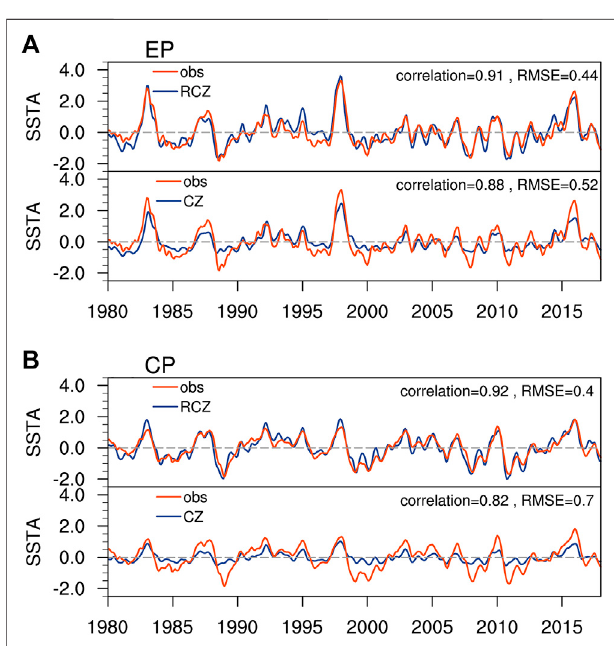
FIGURE 8 | (A) upper panel : Time series of the observed (red line) and RCZ-simulated (blue line) equatorial (5 ° S – 5 ° N average) EP SSTA (i.e., averaged between 140 ° W and 90 ° W). The correlation between the red lineandtheblueline,alongwiththestandardizedrootmeansquareerror of the simulated EP SSTA, is indicated in the upper-right corner. Settings of the model simulation are the same as that in Figure 5 . SSTA has been smoothedthroughthe3-monthrunningaverage. (A) lowerpanel :Sameasthe upper panel, except that the blue line denotes the CZ model-simulated equatorial EP SSTA. (B) Same as (A) but for the equatorial CP SSTA (i.e., averaged between 170 ° E and 140 °